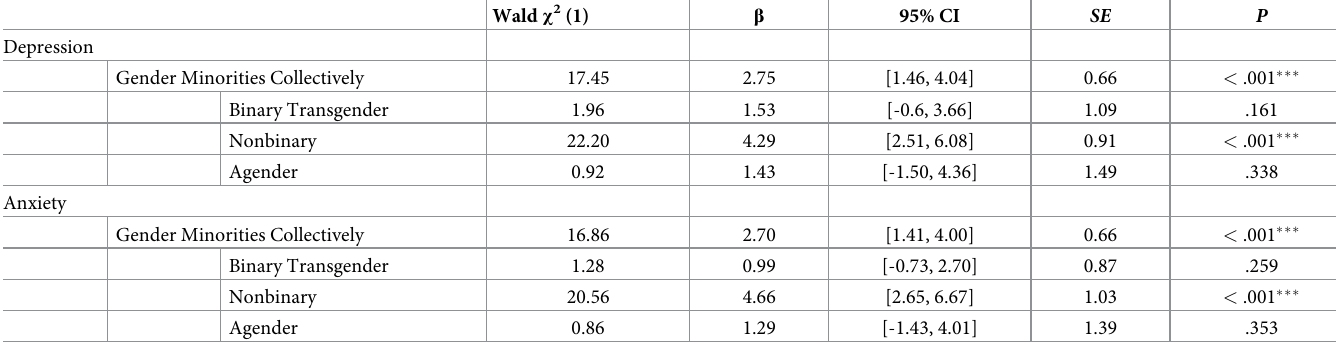
Table 6. Comparing gender minority individuals to cisgender individuals on anxiety and